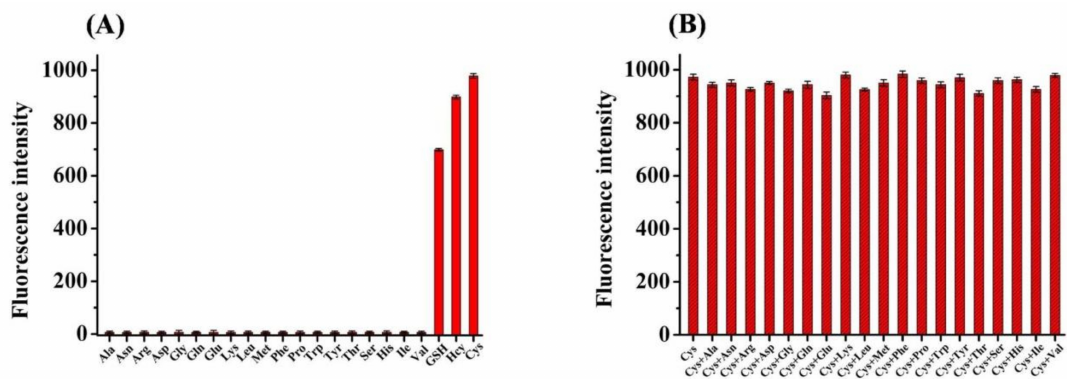
Figure 4. ( A ) The fluorescence intensity at 530 nm of probe 1 (5.0 µ M) upon the addition of the various common amino acid (from left to right: 100.0 µ M for Ala, Asn, Arg, Asp, Gly, Gln, Glu, Lys, Leu, Met, Phe, Pro, Trp, Tyr, Thr, Ser, His, Ile, Val, GSH, Hcy, Cys). ( B ) The fluorescence intensity at 530 nm of probe 1 (5.0 µ M) to Cys (100.0 µ M) with the competition amino acid in the solution containing PBS buffer (pH = 7.4, 50.0 mM) and 20% of DMSO. The error bar represents the standard deviation of three independent experiments ( λ exc = 413 nm, and t = 15